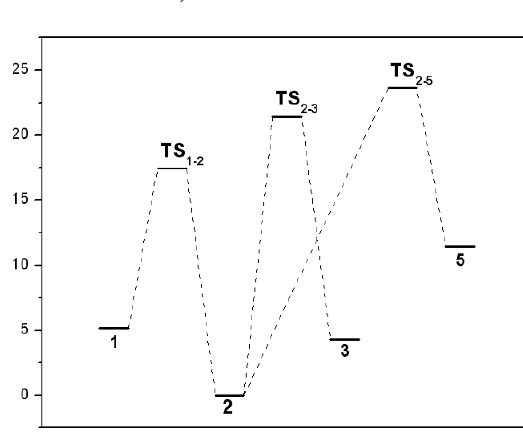
Figure 3. The energy profiles in kcal mol -1 obtained from MP2/6-31G(d,p)//B3LYP/6-311++G(d,p) calculations for the different conformational interconversions of trisarcosyl.